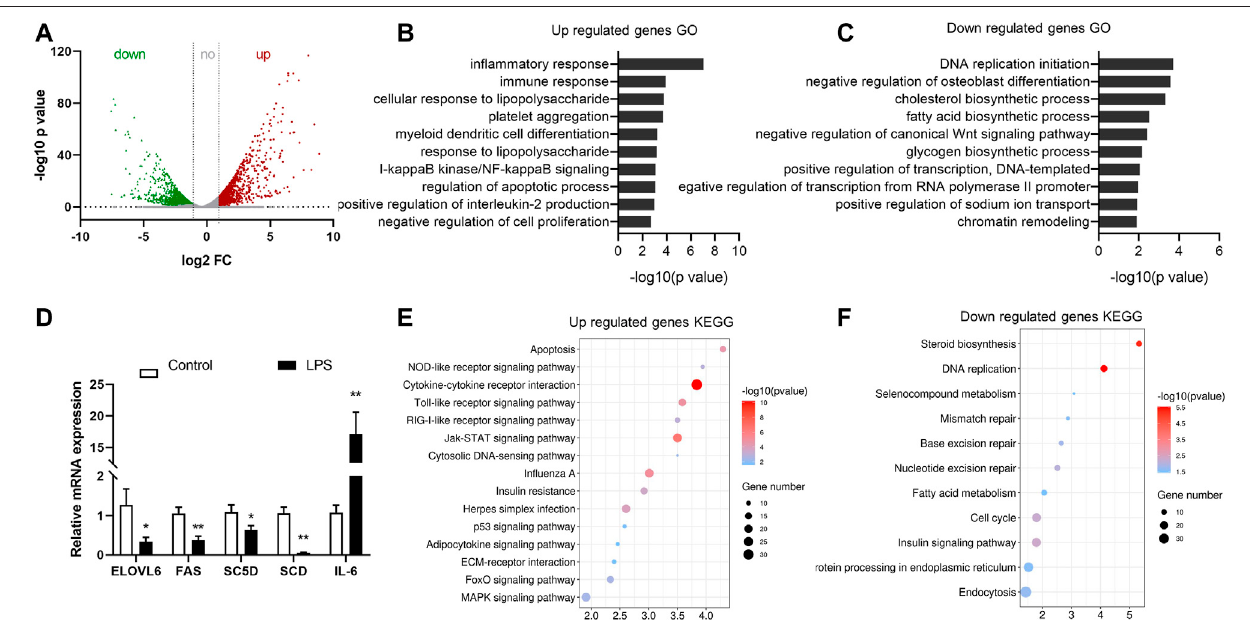
FIGURE 4 | Identi fi cation of differentially expressed genes in LPS-treated group by RNA-seq. (A) Upregulated and downregulated genes in the LPS group compared with the control (fold change > 2, p < 0.05). (B,C) Gene ontology analysis of biological process of the differentially expressed genes. The top 10 enriched GO terms were shown in columns with − log10 ( p -value) indicating the signi fi cance. (D) Real-time PCR validation of the expression of genes. (E,F) Gene set enrichment pathway analysis of genes differently expressed in LPS-treated samples.